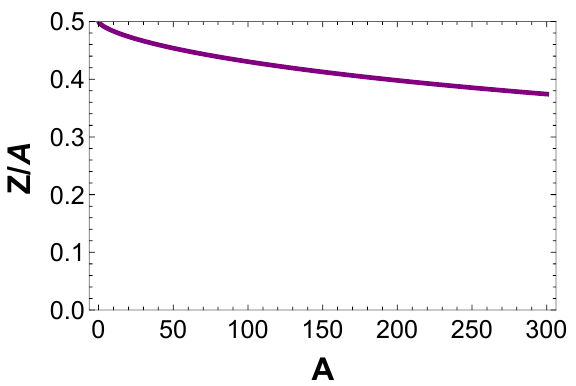
Figure 3: Fraction of protons in most stable configuration, given by semi-empirical mass